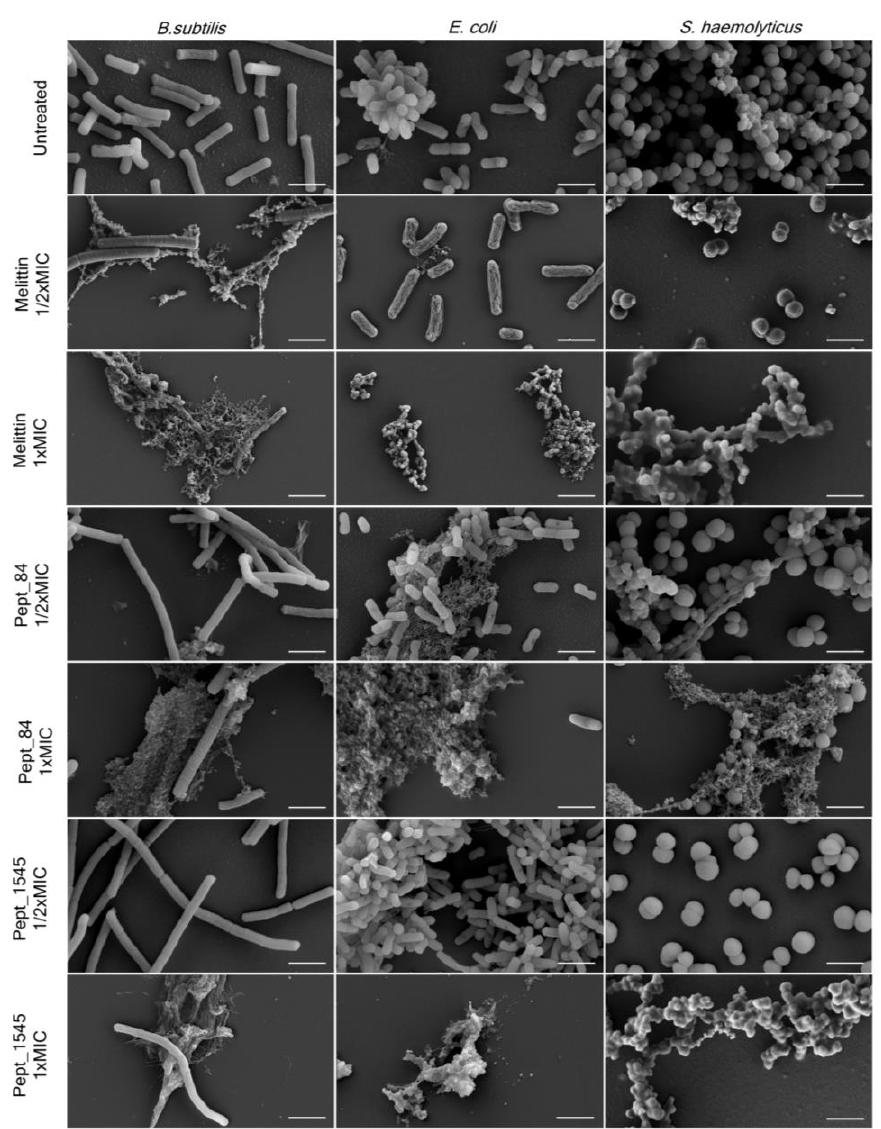
Figure 3. AMPs affect the bacterial membrane integrity. Scanning electron microscopy (SEM) images of bacterial strains treated with peptides pept_84 and pept_1545 and a positive control, melittin B. subtilis and E. coli were treated with peptides at a final concentration equal to 1/2× and 1× MIC for 8 h, and S. haemolyticus was treated with peptides at a final concentration equal to 1/2× and 1× MIC for 24 h. Scale bars: 2 μm.